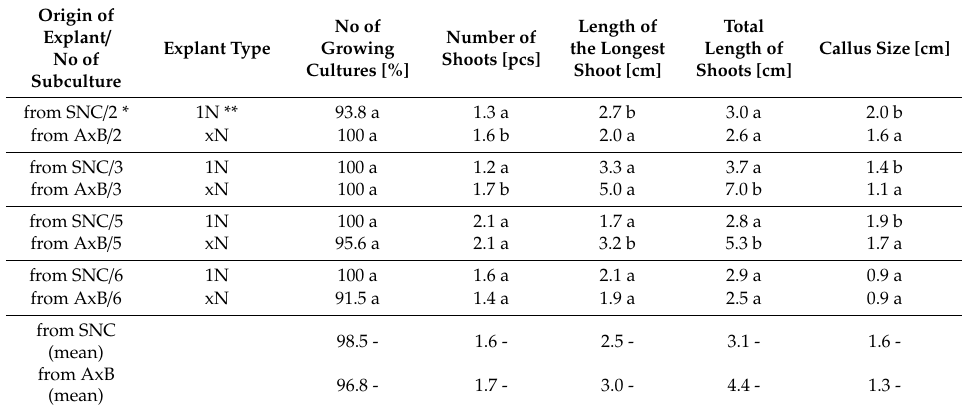
Table 5. Growth of mountain mulberry ‘Kenmochi’ in vitro cultures on standard (“AxB”) medium established from explants prepared from “AxB” and “SNC” cultures.